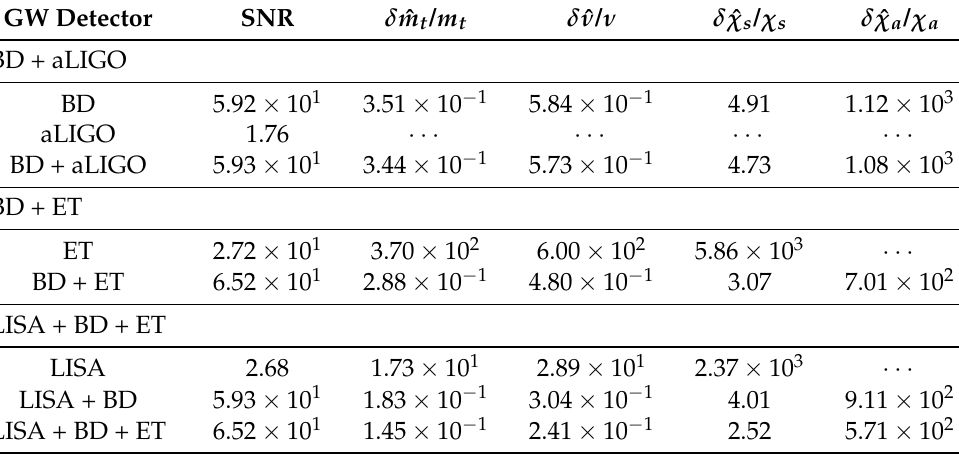
Table 2. Parameter estimation errors of mass parameters ( m , ν ) and spin parameters ( χ s , χ a ) for the GW190521-like quasicircular BBH inspiral, normalized to the total multiband SNR ρ tot ; for example, the result of “BD” in “BD + aLIGO” is normalized to ρ tot = 5.93 × 10 1 . We assume that the true binary parameters are given by the median values of Table 1—i.e., m t = 151.0 M (cid:12) , ν = 0.246, χ s = 0.71, and χ a = 0.02. Since the source location can be determined well by B-DECIGO (BD here) [9,39], we